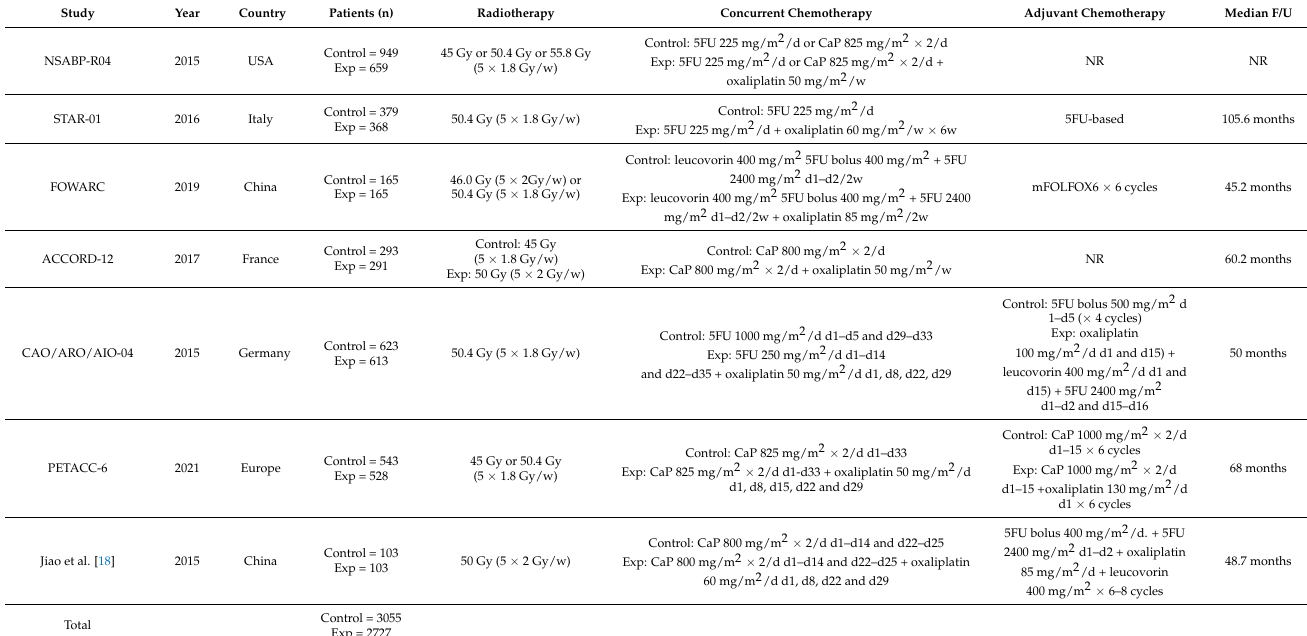
Table 1. Characteristics of included studies.